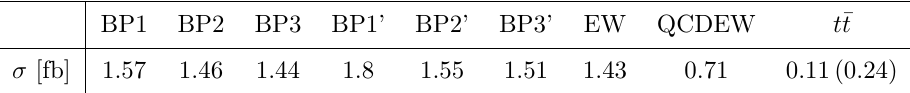
Table 2 . Parton level predictions for the cross sections times the branching ratios of the W bosons to hadrons, (cid:27) ( pp ! W + W ) (cid:2) (BR( W ! hadrons)) 2 in fb, corresponding to the signal points, (cid:0) jj BP1, BP2, BP3, BP1’, BP2’ and, BP3’, and for the main backgrounds: SM-EW (EW), mixed SM-QCDEW (QCDEW) and SM top-antitop ( t (cid:22) t ). In the t (cid:22) t case the decay chain t ! Wb has been considered, and a suppression factor of 0.2 (0.3) for each (cid:12)nal b -jet being misidenti(cid:12)ed as a light jet j has been applied. All the results are generated with MadGraph at the parton level, summed over the interval 800 GeV < M WW < 3000 GeV, and the cuts in eq. (3.1) have been